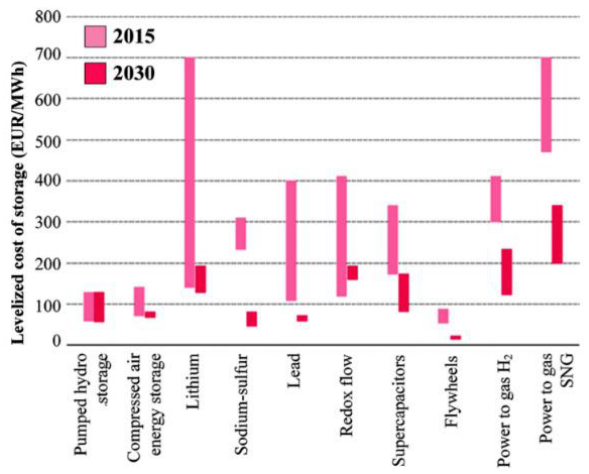
Figure 81. Levelized cost of the storage (LCOS) of 2015 versus the predicted LCOS of 2030 for different types of storage systems [source: World Energy Council, Roland Berger] [242].